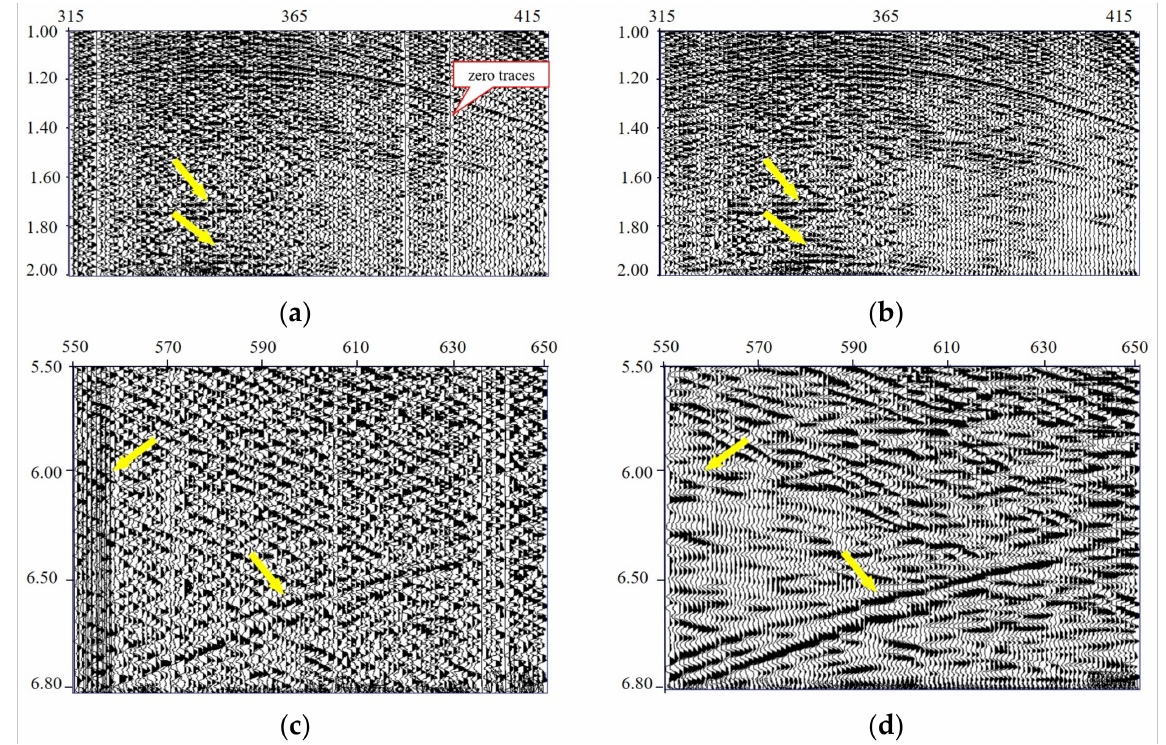
Figure 16. Zoomed sections of the field land data. ( a ) True data (up). ( b ) The denoised results using the proposed method. ( c ) True data (down). ( d ) The denoised results using the proposed method. The fourth example involved worse land field data. The optimized 30%